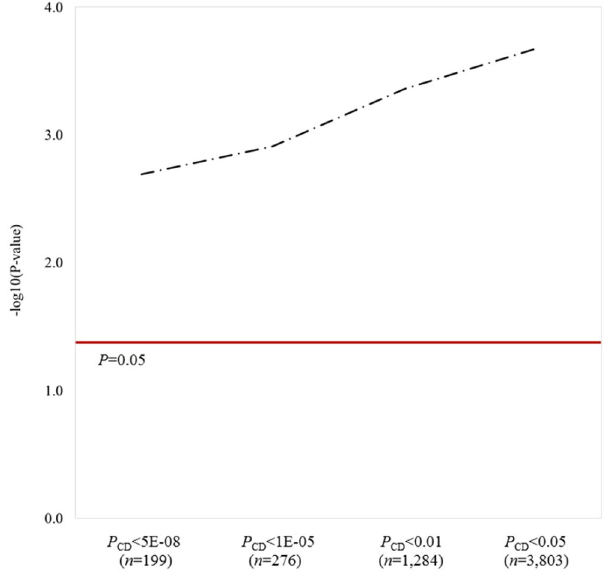
Figure 2. Significance of celiac-PRS profiles for association with overall breast cancer risk. Profiles are based on CD-SNPs under given P CD thresholds. P-values are transformed into negative logarithmic scale base 10. Red solid line denotes threshold for a nominally significant association ( P < 0.05).